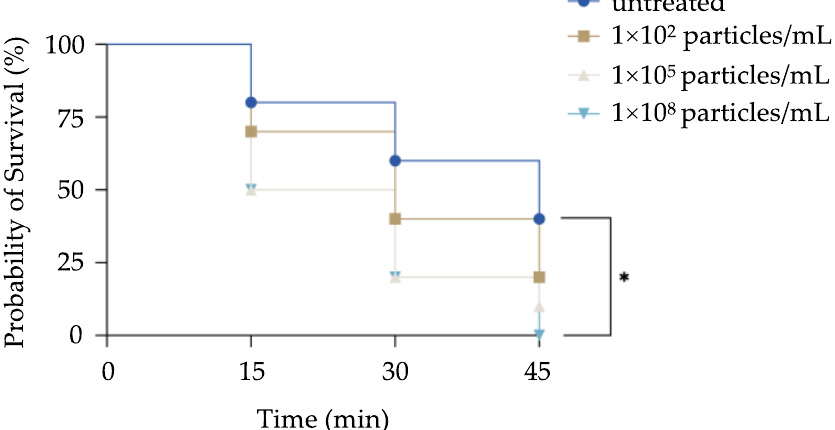
Figure 4. Impacts of MPs exposure on predator evasion by P. bursaria . P. bursaria were exposed to MPs at concentrations of 1 × 10 2 , 1 × 10 5 , and 1 × 10 8 particles/mL, respectively. After 24 h exposure, ten P. bursaria were randomly selected and transferred into a well containing two cyclops . The number of survived P. bursaria was counted every 15 min for an hour and then plotted in a survival curve. The data are represented as the mean ± SD of three independent experiments, and asterisks above the line denote a significant difference (* p < 0.05) between means identified by the line.